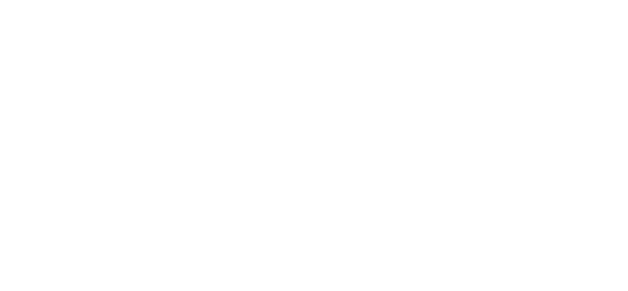
Table 3. Important variable to predict metastasis in gastric cancer